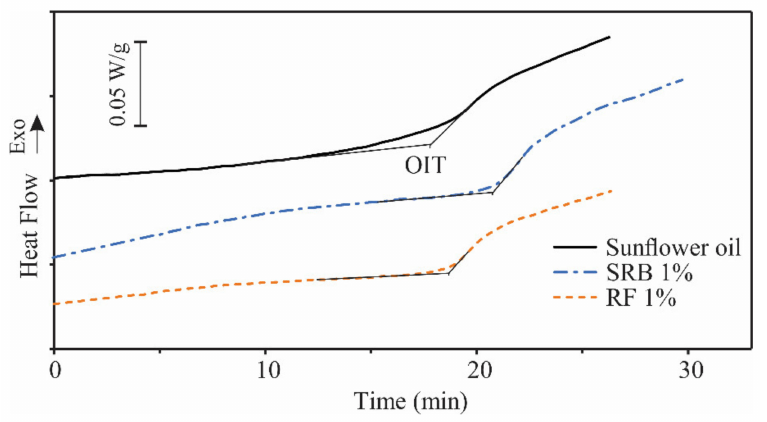
Figure 3. Isothermal DSC oxidation curves of pure sunflower oil and sunflower oil with added Russian (RF) and Serbian (SRB) rosemary essential oil with share of 1% ( w / w ) at 140 ◦ C in oxygen flow 50 mL/min, OIT—oxidation induction time.